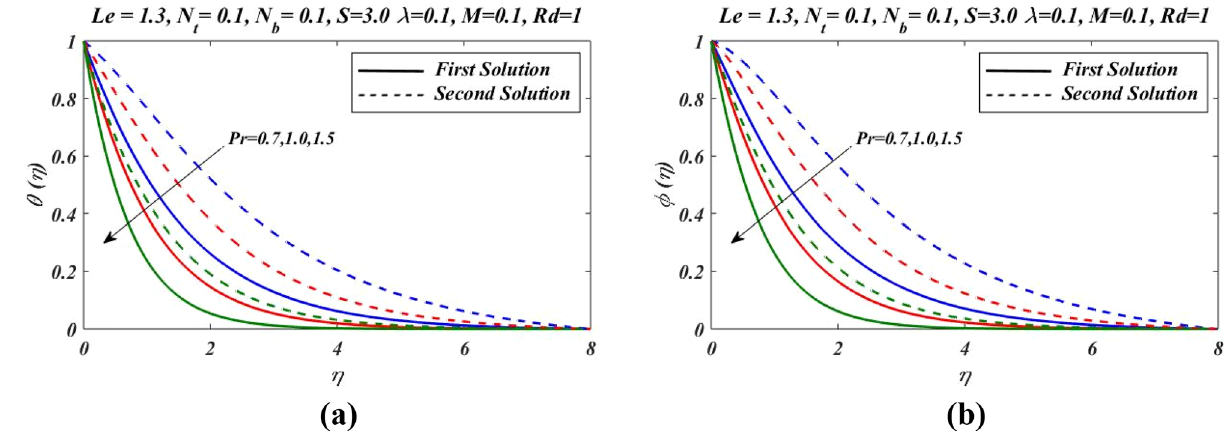
Figure 4. Outcomes of Pr on ( a ) temperature and ( b ) nanoparticles volume